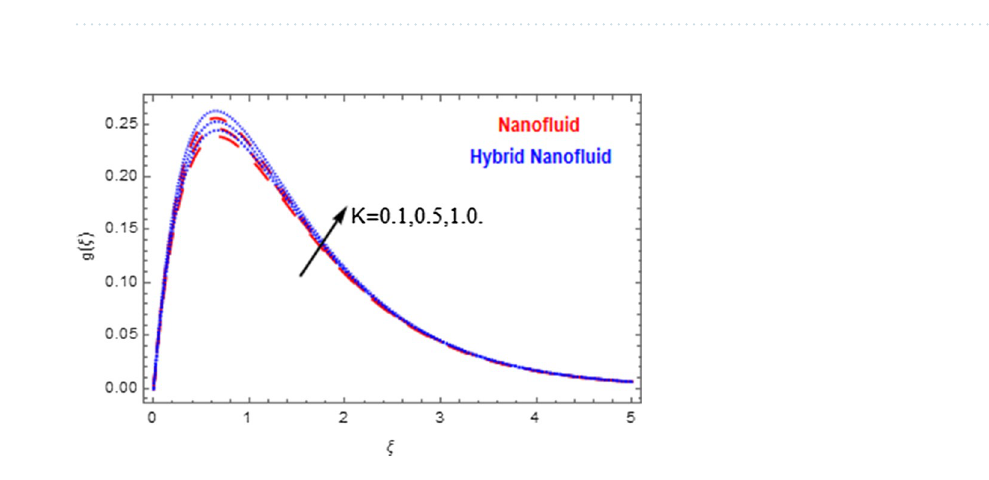
Figure 10. Variation in microrotation field of nanofluid ( Al 2 O 3 ) and hybrid nanofluid ( Al 2 O 3 , Cu ) against different estimations of K when n = 0.5 .